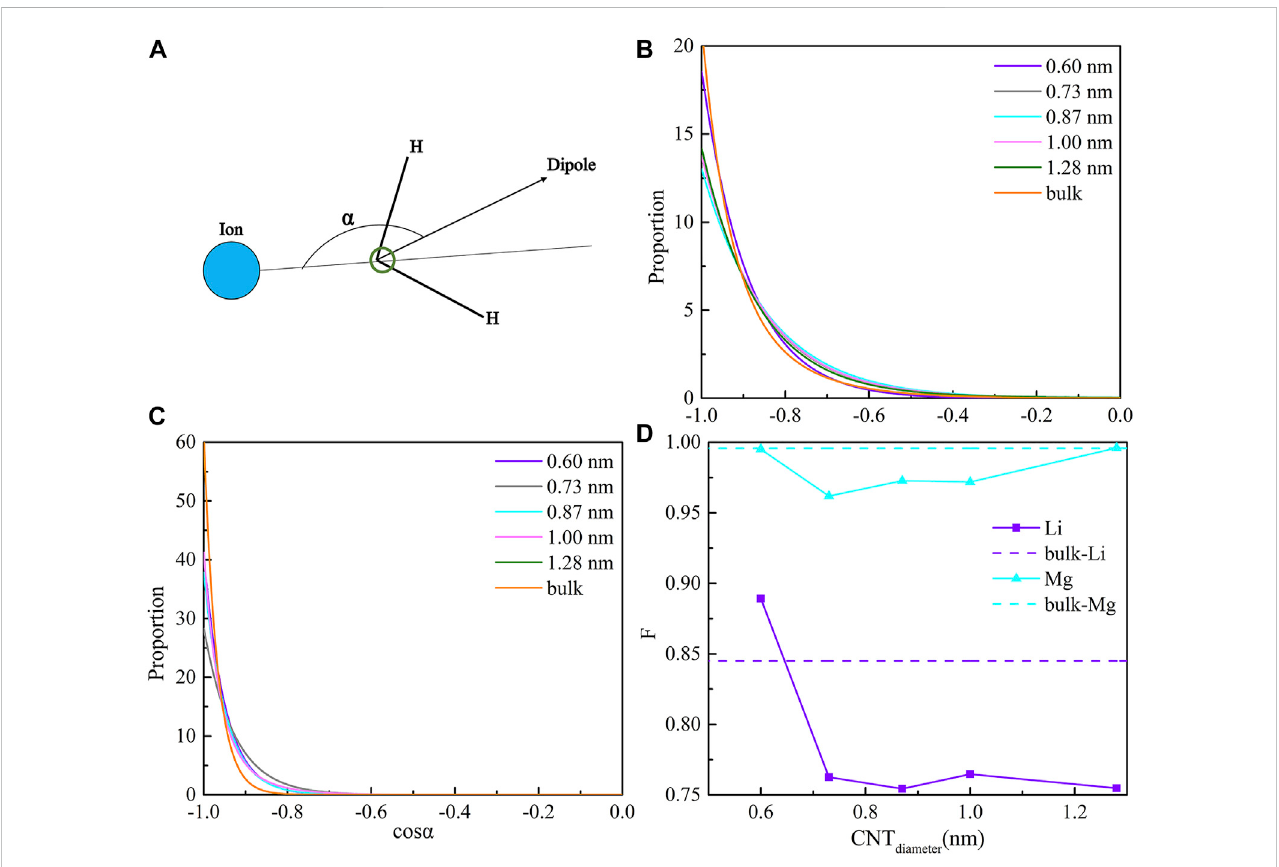
FIGURE 3 Coordination shell order. (A) de fi nition of angle α ; (B) distributions of cos α for Li + in CNT and the bulk solution; (C) distributions of cos α for Mg 2+ in CNTs and the bulk solution; and (D) hydration factor F for Li + and Mg 2+ inside CNTs as a function of diameter.